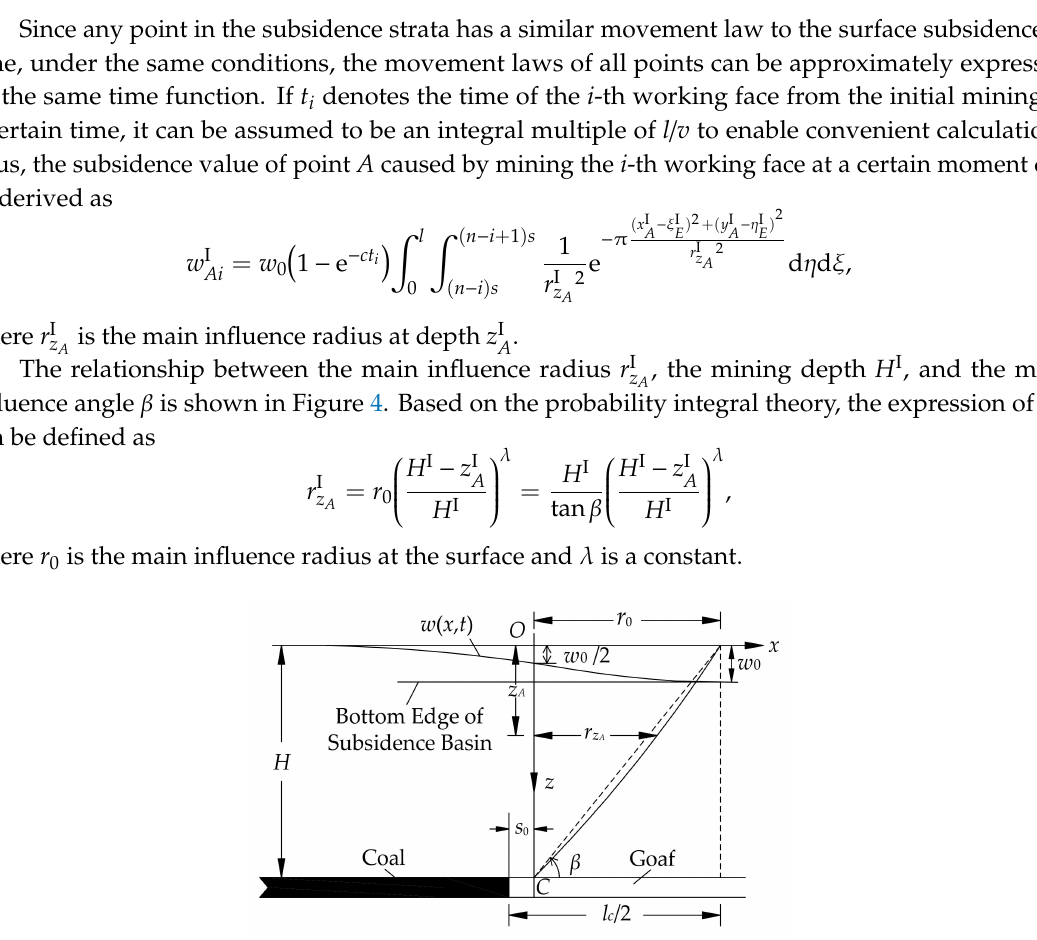
Figure 4. Significance of subsidence parameters caused by